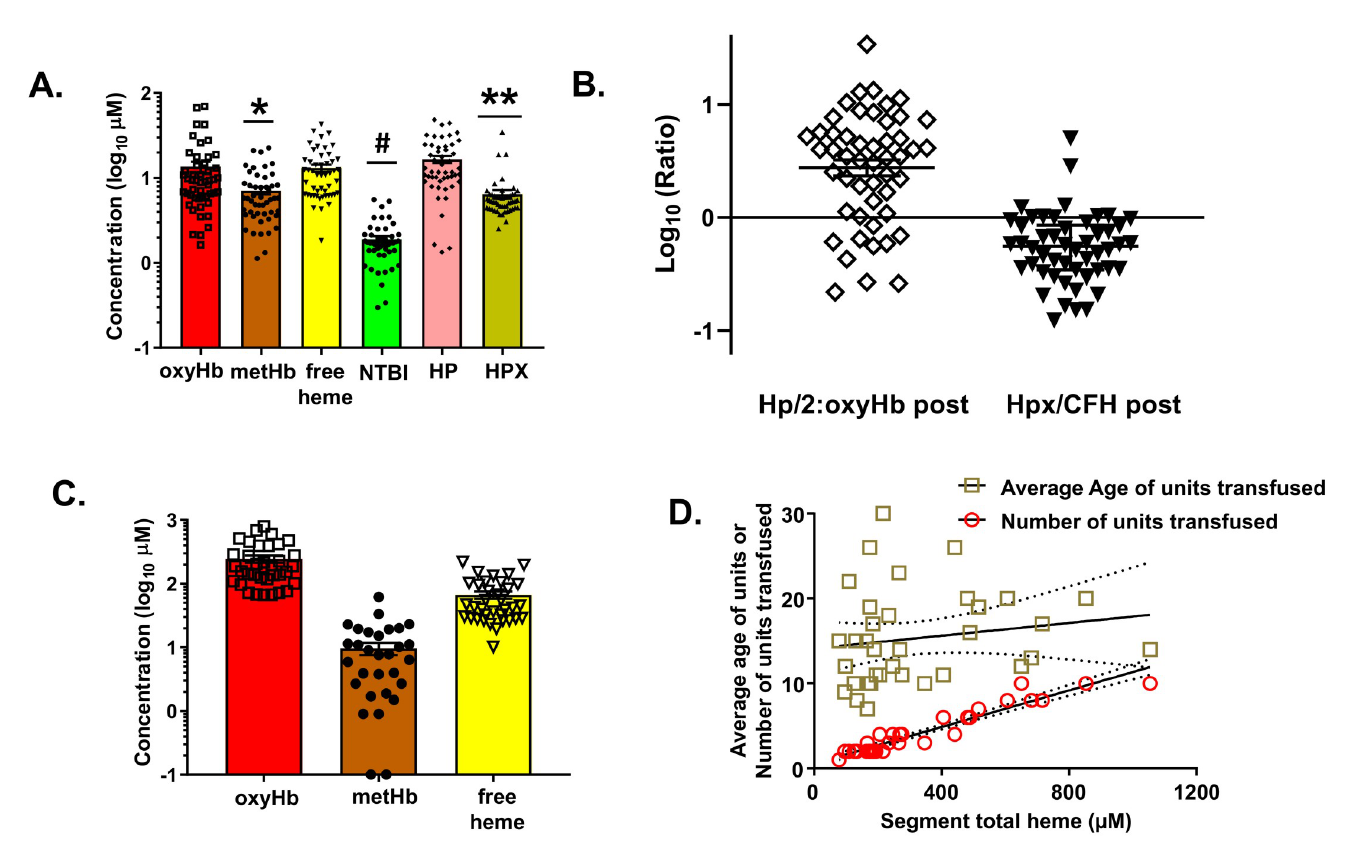
Fig 6. Measurement of hemolysis products and heme-sequestering proteins in transfused units and plasma in TH patients. Fifty TH patients requiring blood product resuscitation admitted to UAB ER between Jan 2015 and Apr 2016 were enrolled. Panel A: oxyHb, metHb, free heme, haptoglobin (Hp) and hemopexin (Hpx) concentrations in plasma from TH patients 2-3h after resuscitation. Data are mean ± SEM. � p = 0.0018 relative to free heme, #p < 0.001 relative to oxyHb, metHb and free heme, �� p < 0.001 relative to Hp and free heme by Kruskal-Wallis with Dunn’s multiple comparison test. Panel B: Molar ratios (log transformed) of Hp:hemoglobin dimer and Hpx:heme. The former is presented as Hp/hemoglobin dimer to reflect the fact that one haptoglobin binds to one hemoglobin dimer. Each data point reflects an individual patient. Data show mean ± SEM. Segments associated with RBC units transfused and plasma from patients after stable resuscitation was collected. Panel C: total oxyHb, metHb and free heme concentrations in segments of RBC units transfused (n = 35). Panel D: Segment concentrations of total heme were plotted against the average age of the transfused RBC or the number of units transfused. Line represents best fit by linear regression with 95% confidence intervals. Slope was significantly non-zero for number of units (r2 = 0.91, p <